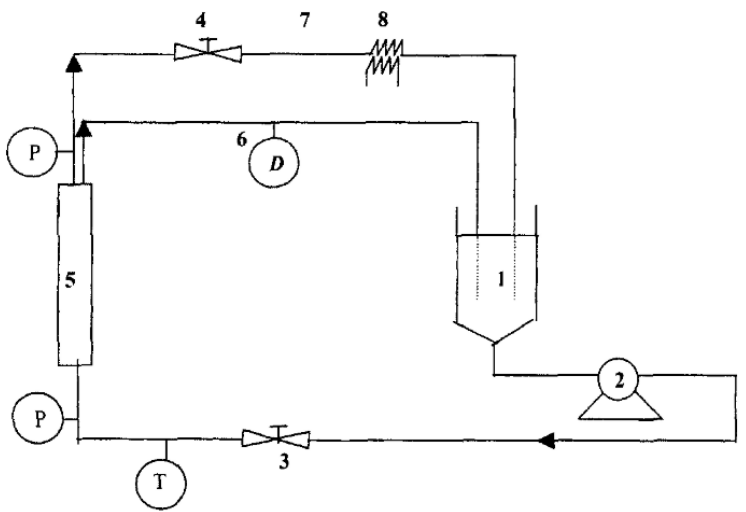
Figure 8. Diagram of the nanofiltration pilot. 1 tank, 2 feed pump, 3 and 4 pressure regulation, valves, 5 nanofiltration module, 6 permeate recirculation, 7 retentate recirculation, 8 heat exchanger. D, flow meter; P, pressure sensor; T, temperature sensor [58].